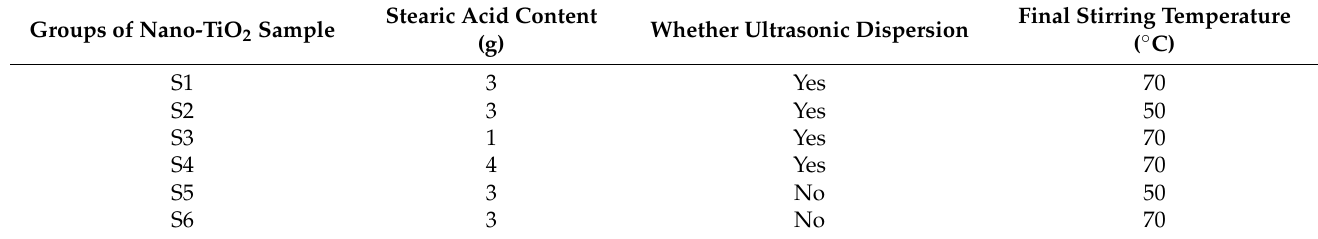
Table 1. Preparation method of hydrophobic nano-TiO 2